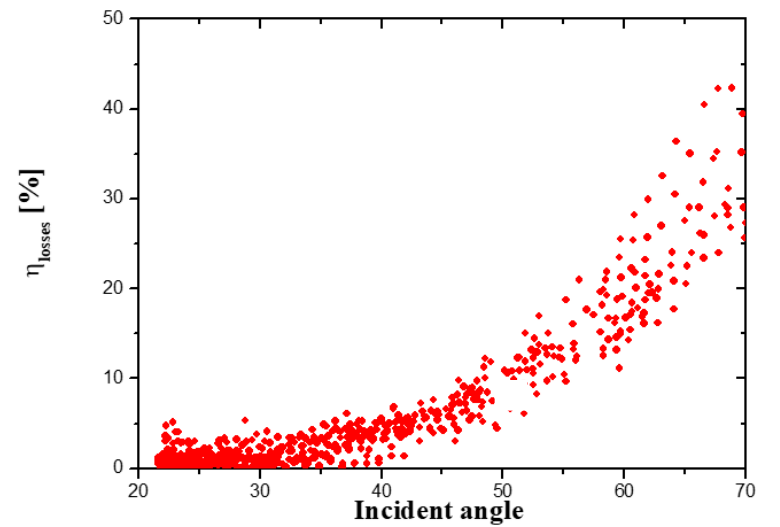
Figure 6. Experimental dependence observed for the optical coupling losses as function of the incident angle.